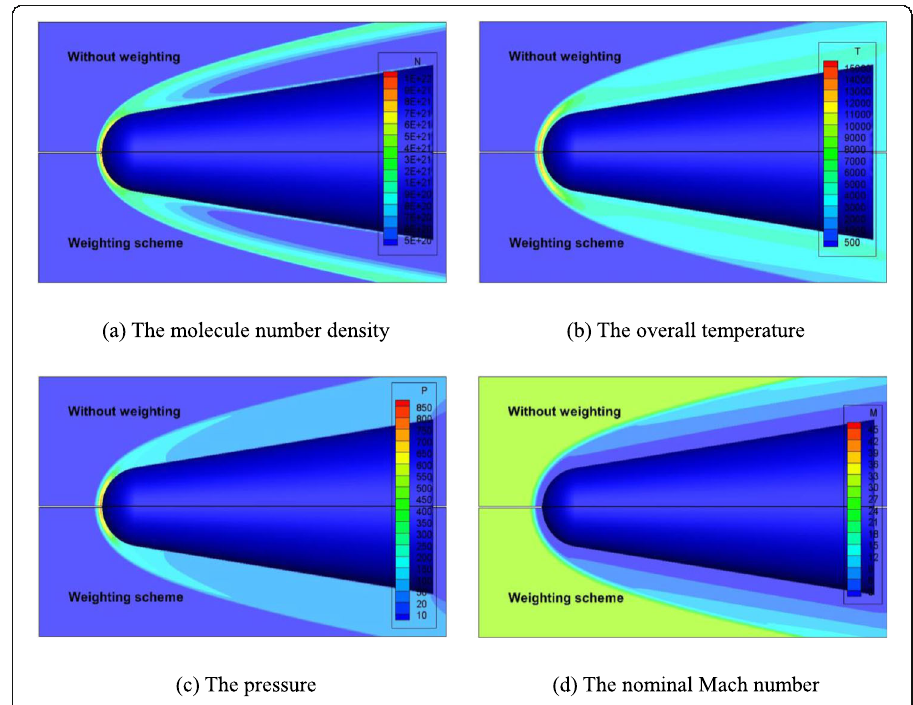
Fig. 6 The macroscopic flow parameters for flow around RAM-C II at 81 km. a The molecule number density. b The overall temperature. c The pressure. d The nominal Mach number